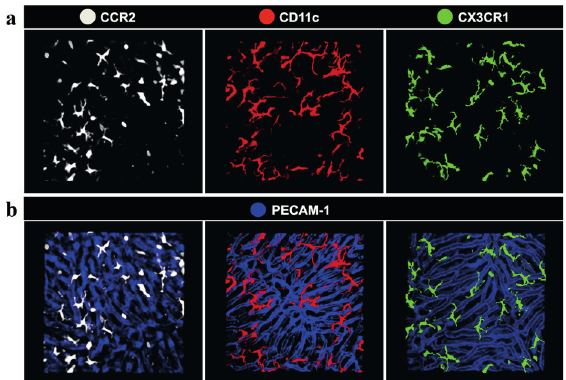
Figure 3 - Three-dimensional rendering of liver phagocytes of different mouse strains. ( a ) liver confocal intravital microscopy imaging through the capsule evidencing the distribution of CCR2 rfp/wt (white), CD11c-YFP (red) and CX3CR1 gfp/wt (green) mice, respectively. ( b ) Image merged with PeCAM-1 to geographically locate these cells within the liver